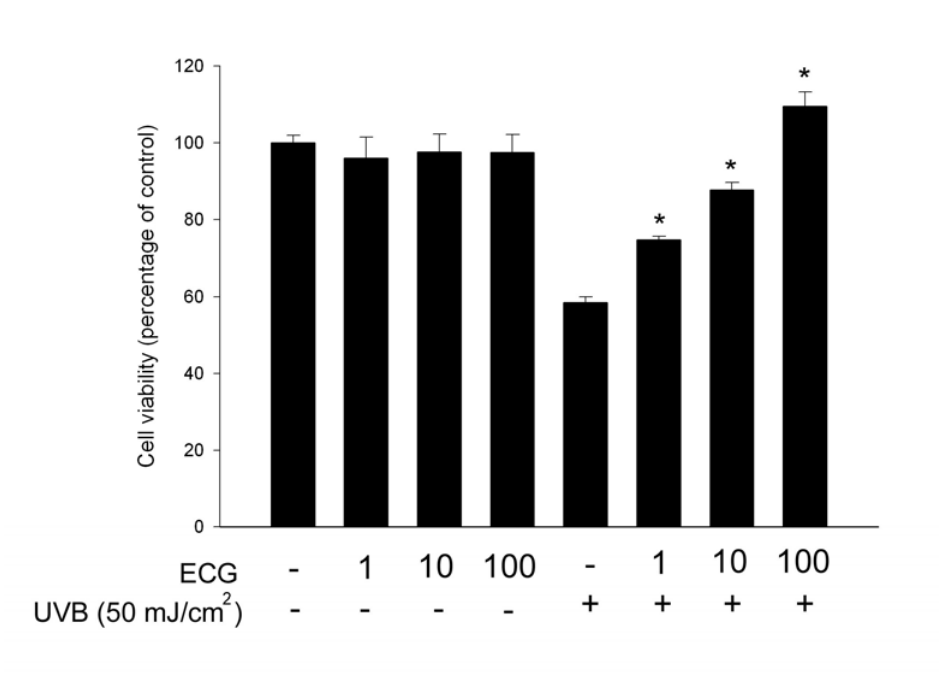
Figure 1. ECG inhibition of UVB irradiation-induced keratinocyte